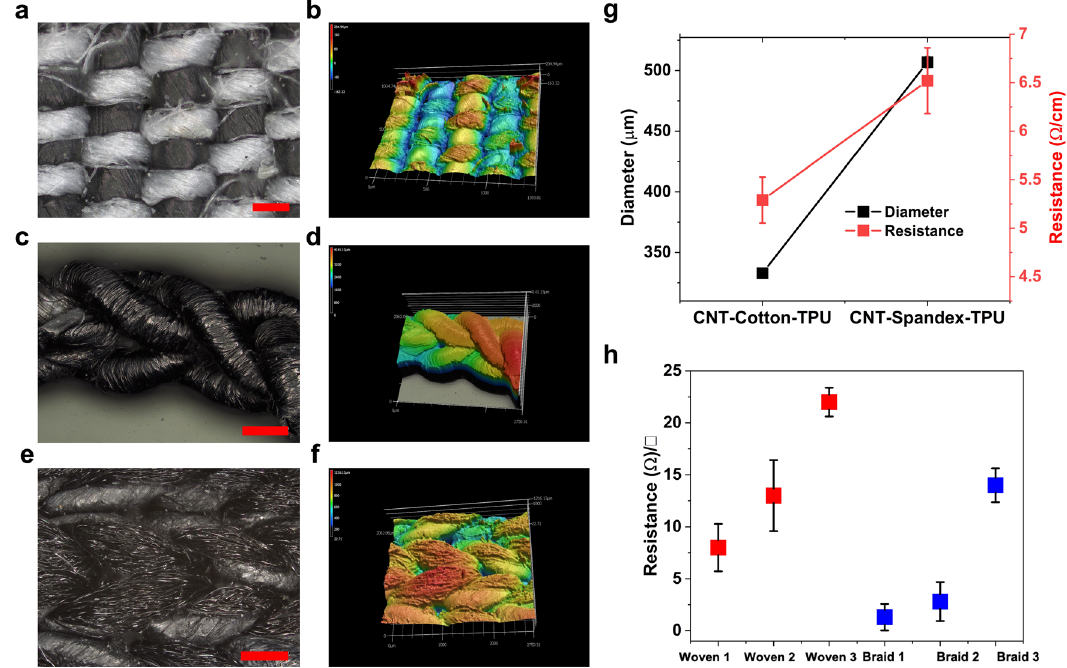
Fig. 2 Morphological and Electrical Characteristics of CNT Textile Electrodes. a Optical microscopic images of the a woven, c braid, e and knit electrodes with corresponding laser pro fi ling images of the b woven, d braid and f knit electrode textile structures. Electrical resistance and diameter of the g CNT wrapped yarns and electrical resistance of h CNT textile electrodes. Data are presented as mean ± SD. The scale bar of the images are 200 microns a and 500 microns c , e